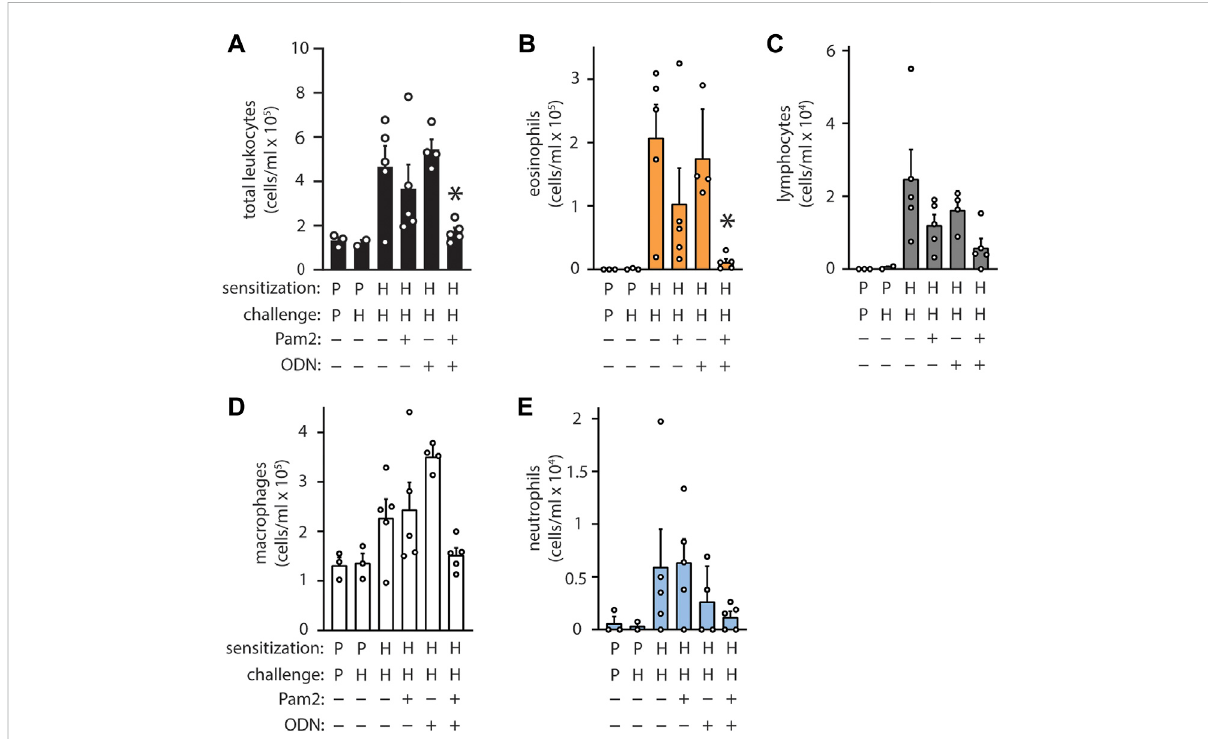
FIGURE 3 Pam2 and ODN interact synergistically to block sensitization to HDM. Pam2, ODN, or Pam2ODN was administered 7 days before sensitization to HDM. Pam2 and ODN treatments were performed in an identical manner and at identical concentrations as Pam2ODN treatments throughout. Quanti fi cation of leukocytes in lung lavage for (A) total leukocytes (B) eosinophils, (C) lymphocytes, (D) macrophages, and (E) neutrophils (N = 3- 5 mice). Bars show mean +/- SEM. P* < 0.005 for synergy between Pam2 and ODN by linear regression. p = PBS. H =